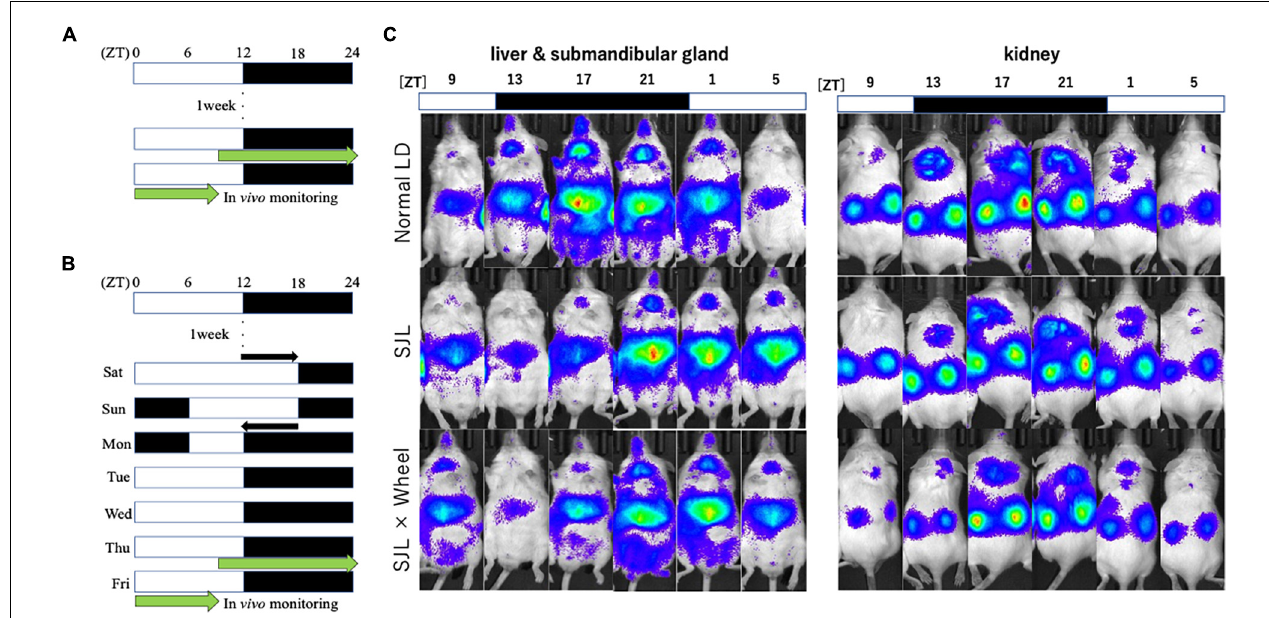
FIGURE 2 | Experimental protocol and representative images of the in vivo imaging system. (A) Protocol of normal LD condition. (B) Protocol of SJL condition. (C) Representative images of in vivo PER2:LUCIFERASE (PER2:LUC) bioluminescence showing PER2:LUC expression rhythm as luminescence in the kidney, liver, and submandibular